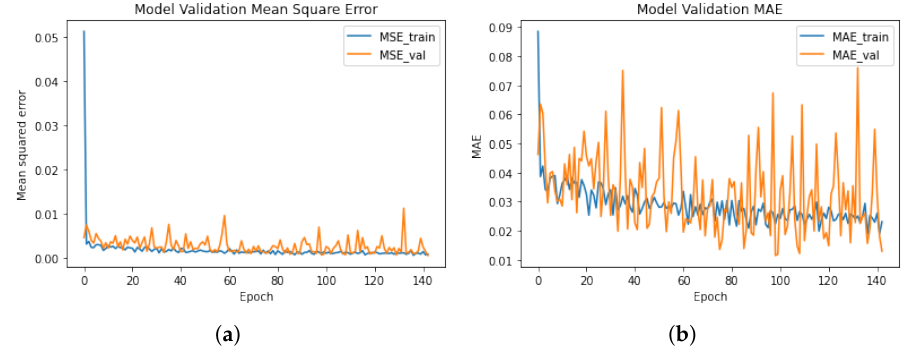
Figure 10. Validation curves for cruciform inverse model: ( a ) MSE and ( b )